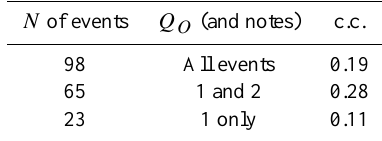
Table 3. Linear correlation coefficients for 2 R O vs. | CA |